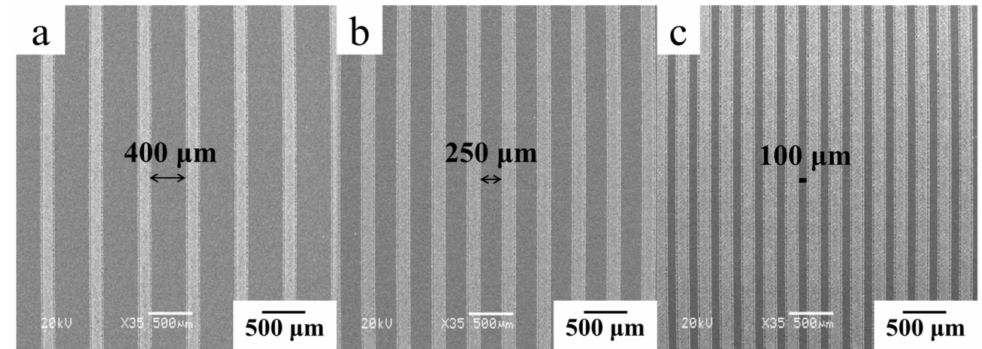
Figure 1. SEM micrographs of the textured surfaces with different spacings: 400 µ m ( a ), 250 µ m ( b ), and 100 µ m ( c ).